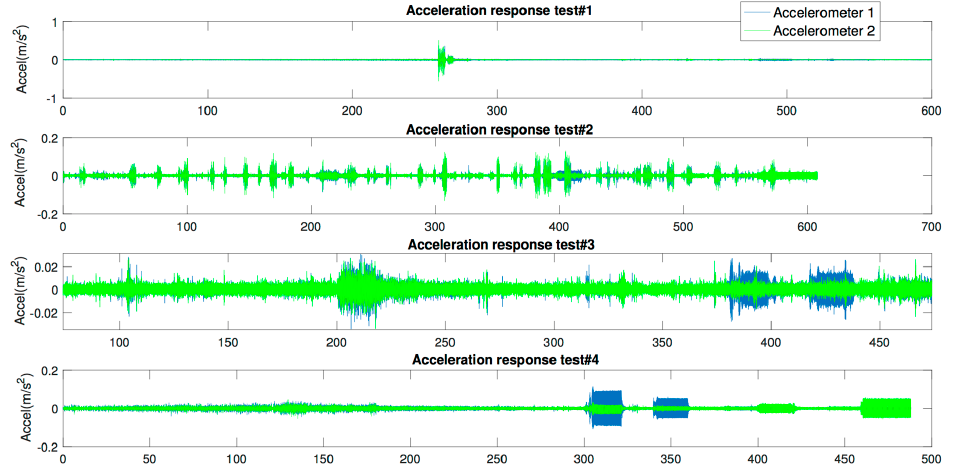
Figure 9. Registered acceleration time-histories of the four tests (time in s).